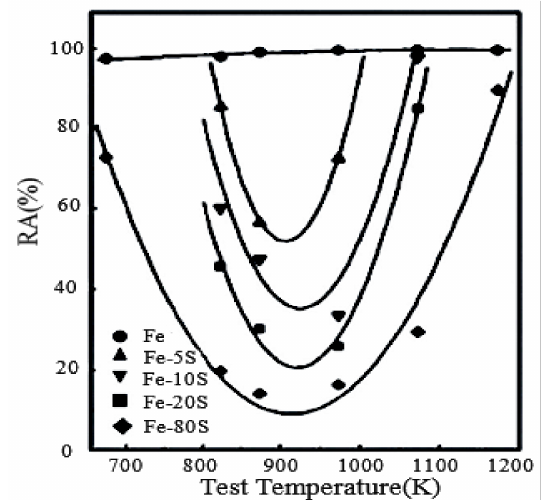
Figure 12. Variation of RA with test temperature for Fe with different levels of S in ppm. Reprinted with permission from ref. [14]. Copyright 1999 Acta Metallurgica Sinica (English Letters).